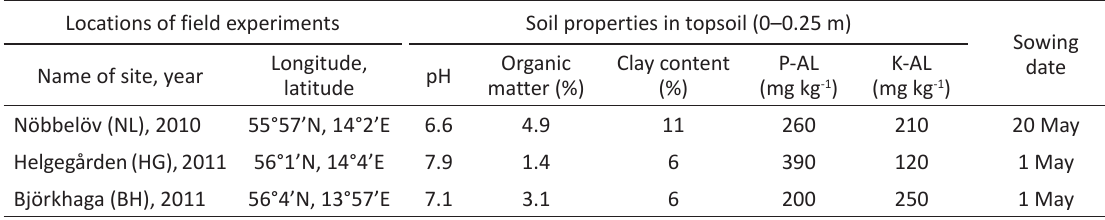
Table 1. Sites and locations of field experiments, soil properties and dates of sowing Locations of field experiments Soil properties in topsoil (0–0.25